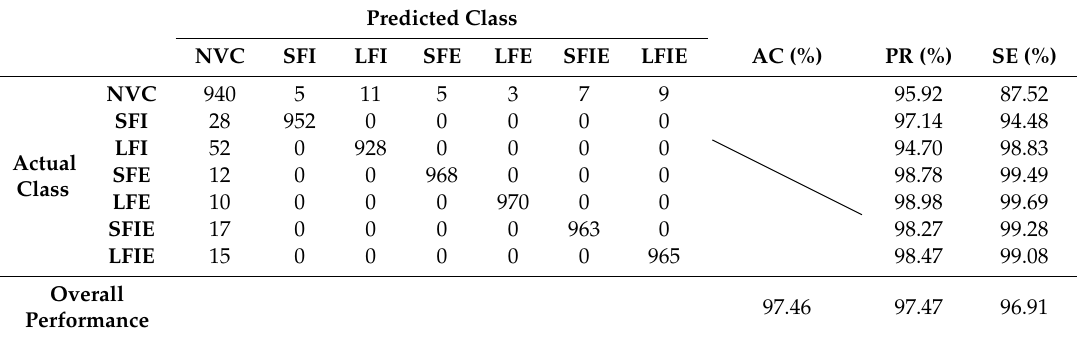
Table 4. Confusion matrix of seven valve clearance states of first trial with the high-level